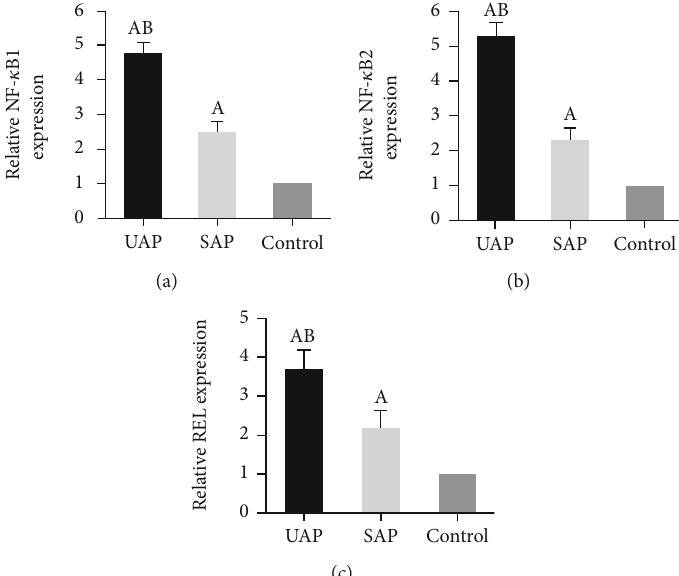
Figure 5: Comparison of NF- κ B1, NF- κ B2, and REL mRNA levels. (a – c) Comparison of NF- κ B1, NF- κ B2, and REL mRNA levels, respectively. A and B suggested the di ff erence was obvious to the control group and SAP group, respectively ( P < 0 : 05